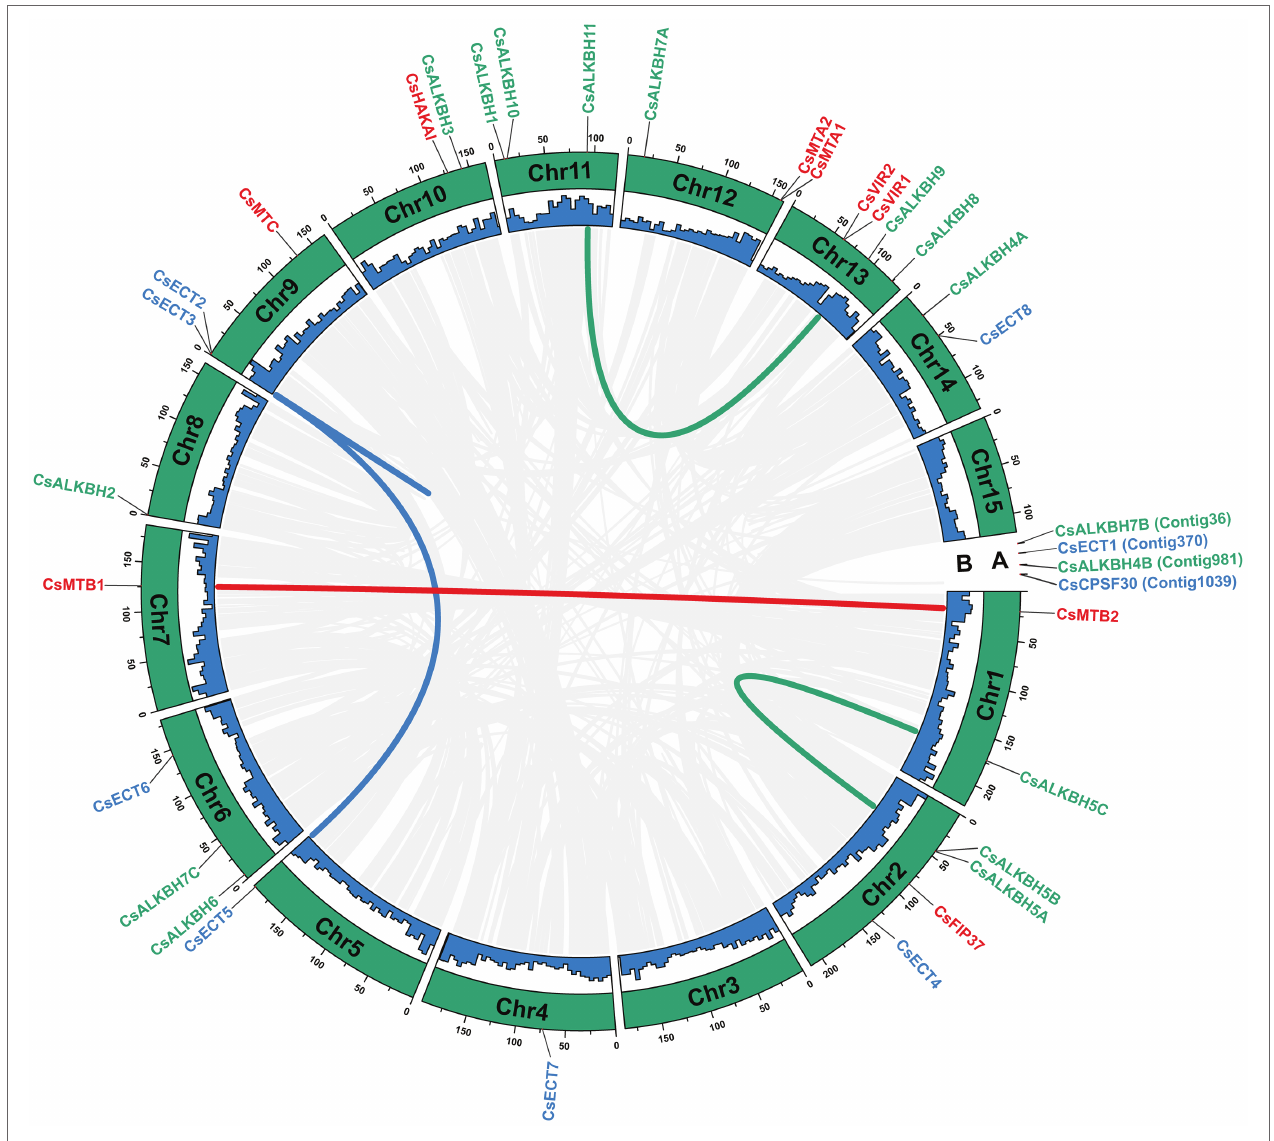
FIGURE 4 | Chromosomal distribution and collinearity analysis of m6A regulatory genes in tea plants. (A) Chromosomal number. (B) GC content. The gray lines represent all collinear blocks in the genome of tea plant. The other colored lines represent all collinear relationships of m6A regulatory